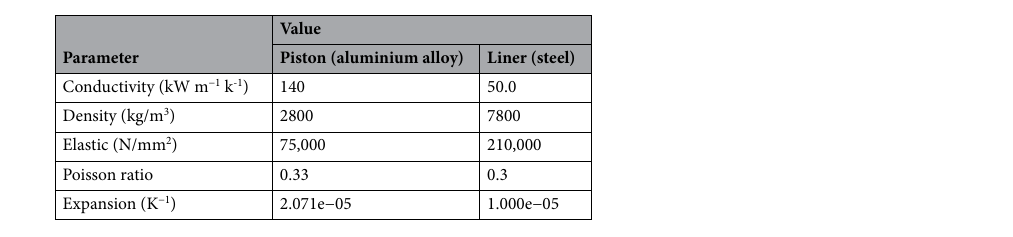
Table 2. Main material properties of piston and liner.